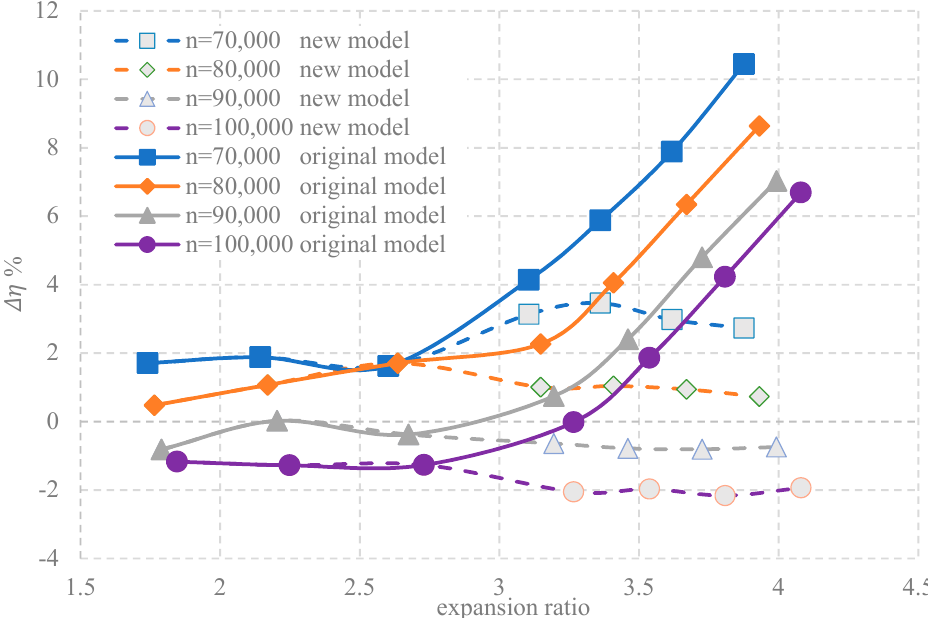
velocity (cid:1829) (cid:3040)(cid:2872) at the inlet and (cid:1829) (cid:3040)(cid:2874) at the outlet. So, (cid:1829) (cid:3051) and (cid:1829) (cid:3045) will decrease with the in ‐